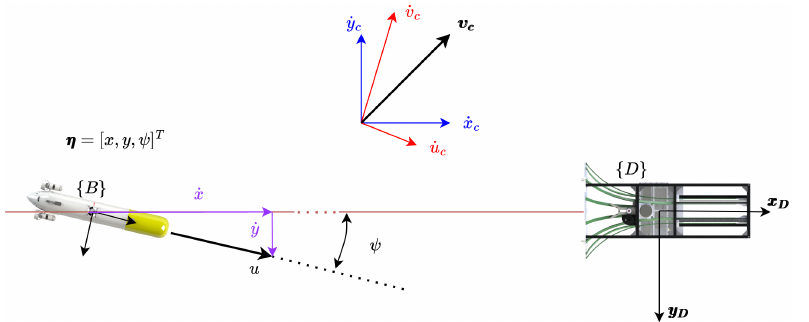
Figure 1. Geometrical representation of basic variables. Two different reference frames are presented, the { D } frame located at the position of the DS, and the { B } frame attached to the AUV body. The velocity in the { D } frame are symbolised by ˙ x and ˙ y with respect to the ground, and the velocities in the { B } frame are, with respect to the water, represented by u and v